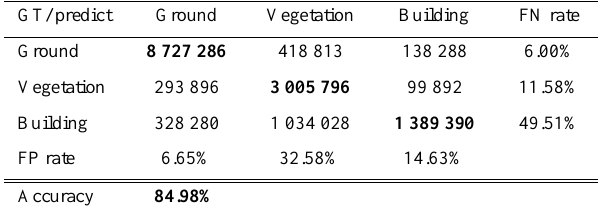
Table 5. Model 2 results for the AHN2 test set. For AHN2 similar results are obtained as for AHN3 (compare Table